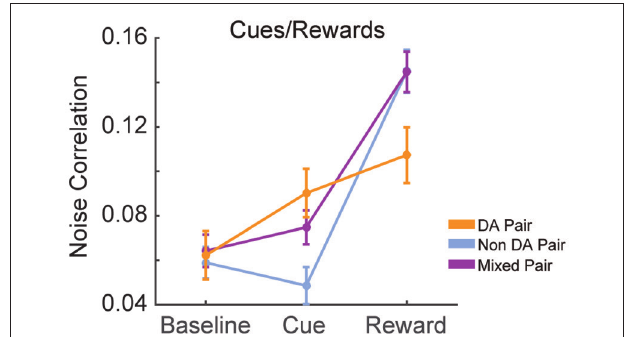
FIGURE 10 | Correlation structure of cue and reward evoked responses. Mean ± SEM noise correlation between simultaneously recorded pairs of VTA neurons in RR10 sessions, during baseline, cue onset, and reward delivery. Data depicted separately for all pairings of neurons. Note that reward delivery evoked the largest magnitude noise correlations in all